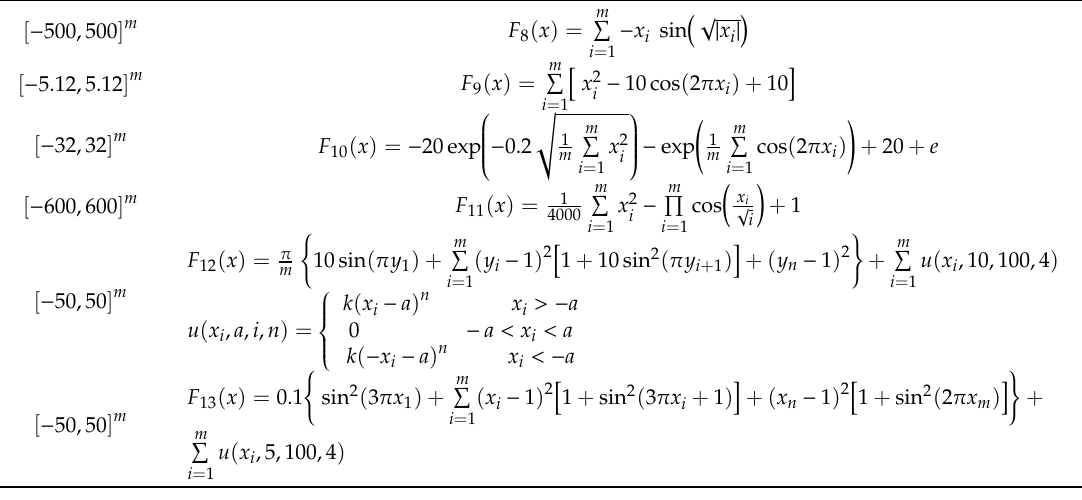
Table A9. Multimodal test functions.